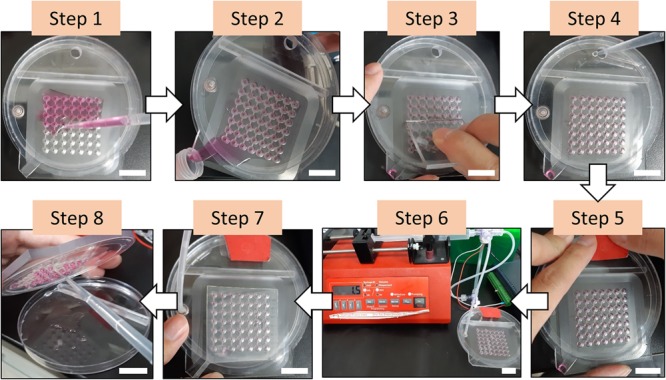
The procedure of forming the hanging drops using the PANDA system. Step 1: Add the cell suspension on the well plate. Step 2: Pour the excess cell suspension into a centrifuge tube. Step 3: Use a scraper to remove the residue. Step 4: Fill the reservoir with PBS through the loading hole. Step 5: Seal the loading hole. Step 6: Connect with the syringe pump to initiate the withdrawal of air and wait until all hanging drops are formed. Step 7: Seal the wells using the sealing sheet. The PANDA system is now ready for cell culture. Step 8: After cell culture, disassemble the chip and collect the hanging drops using a pipette for further experiments. All scale bar represent 2 cm.